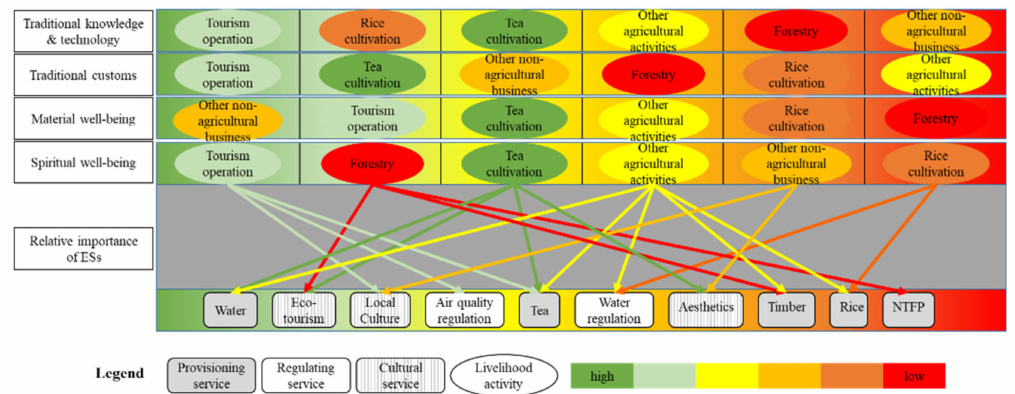
Figure 8. Illustration of the linkages among cultural inheritance, livelihood strategies, ecosystem services, and social well- being. The spectrum from green to red represents the decreasing value of certain variables. The colourful oval represents livelihood activity with certain average incomes illustrated by the colour from the spectrum. The relative importance of the 10 ESs ordered by their scores are illustrated with arrow lines with respect to livelihood